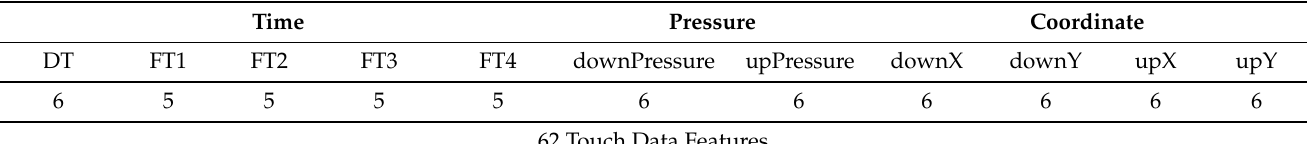
Table 2. The number of touch data